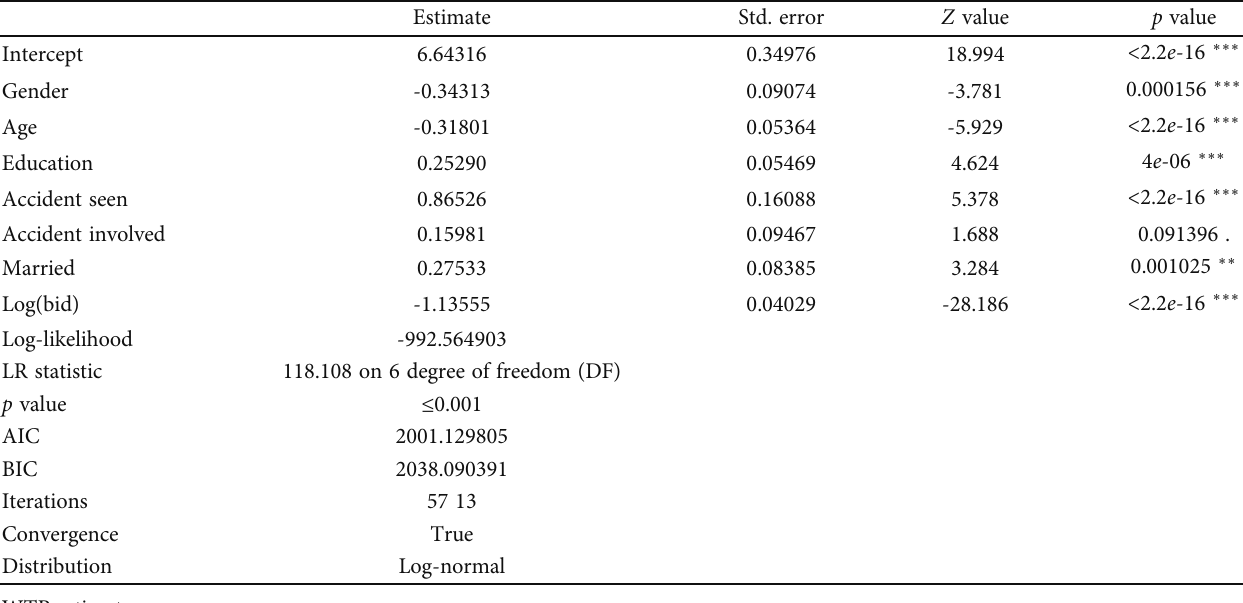
Table 8: Parameter estimates of the log-normal model (source: